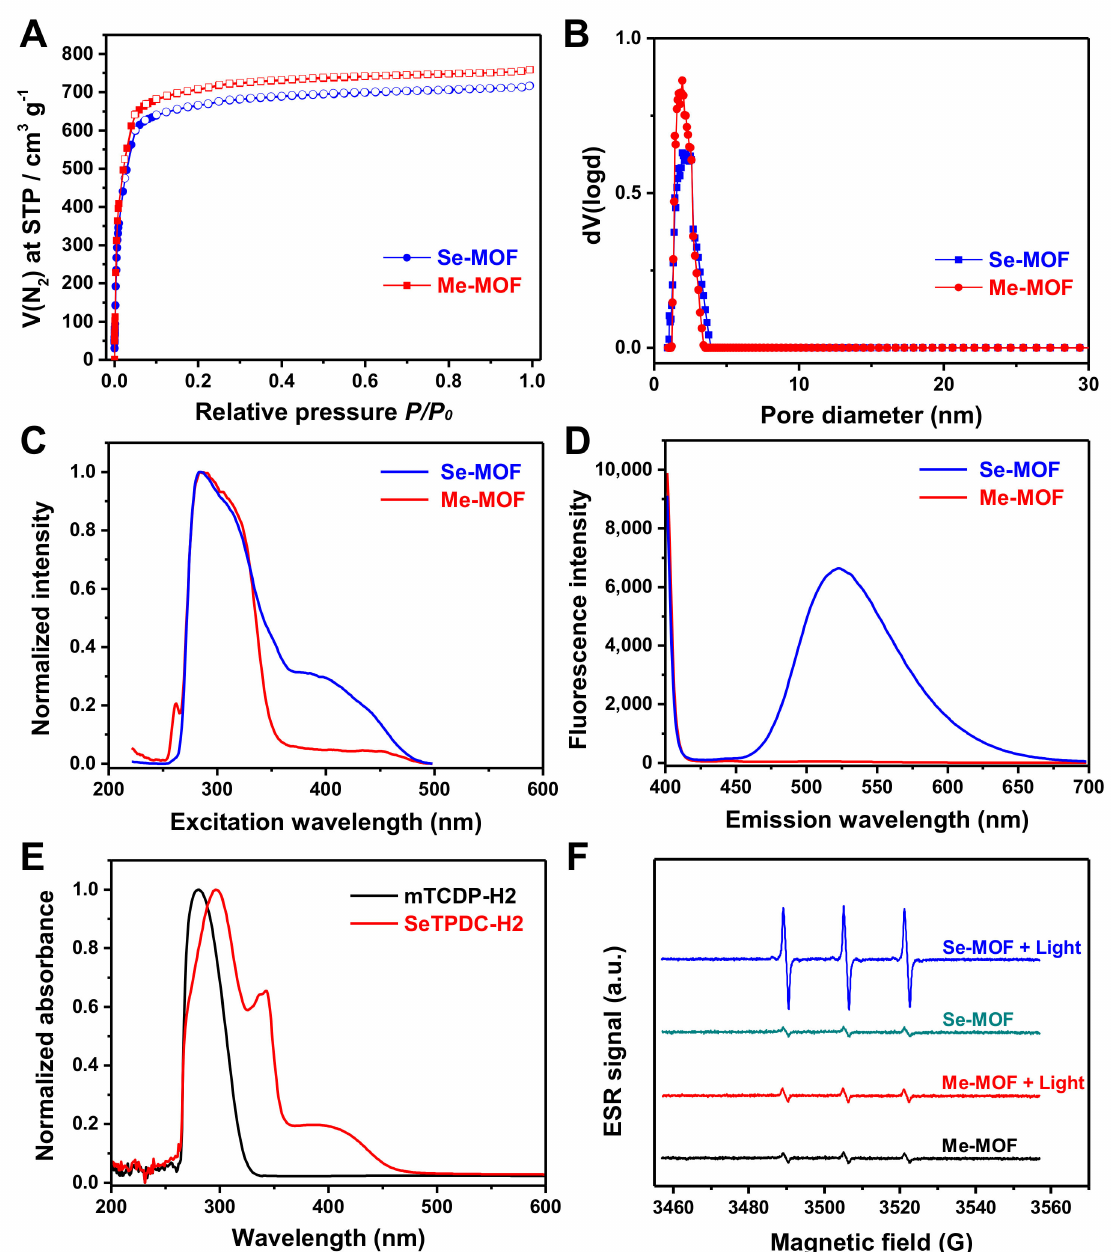
Figure 3. ( A ) Nitrogen sorption isotherms and ( B ) Barrett − Joyner − Halenda pore distribution of the Me-MOF and Se-MOF. ( C ) Excitation spectra ( λ em = 522 nm) and ( D ) emission spectra ( λ ex = 390 nm) of the Me-MOF and Se-MOF dispersed in DMF. ( E ) UV − vis absorption spectra of mTPDC-H2 and SeTPDC-H2 in DMF. ( F ) ESR spectra of a PBS solution (pH 7.4) containing Me-MOF or Se-MOF before and after light irradiation (450 nm, 3 mW cm − 2